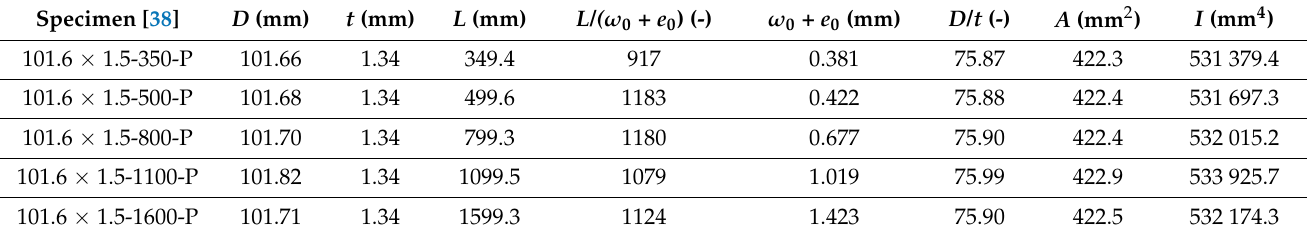
Table 7. Measured and calculated geometric properties of the cross-section set 101.6 × 1.5 CHS pin-ended columns (ferritic